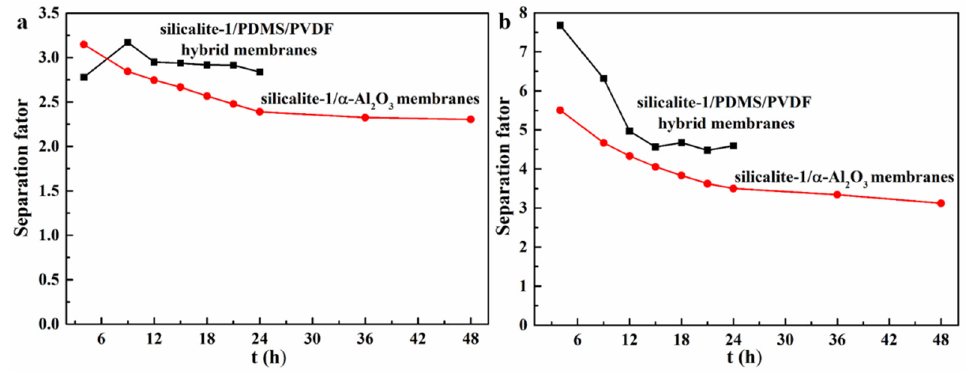
Figure 13. Separation factor results of the silicalite-1/ α− Al 2 O 3 membranes [3] and the silicalite- Separation factor results of the silicalite-1/ α − Al 2 O 3 membranes [3] and the 1/PDMS/PVDF hybrid membranes in binary − isomer solutions (of equal molar content): ( a ) silicalite-1/PDMS/PVDF hybrid membranes in binary − isomer solutions (of equal molar p/o − DCB; ( b ) p/m − DCB.